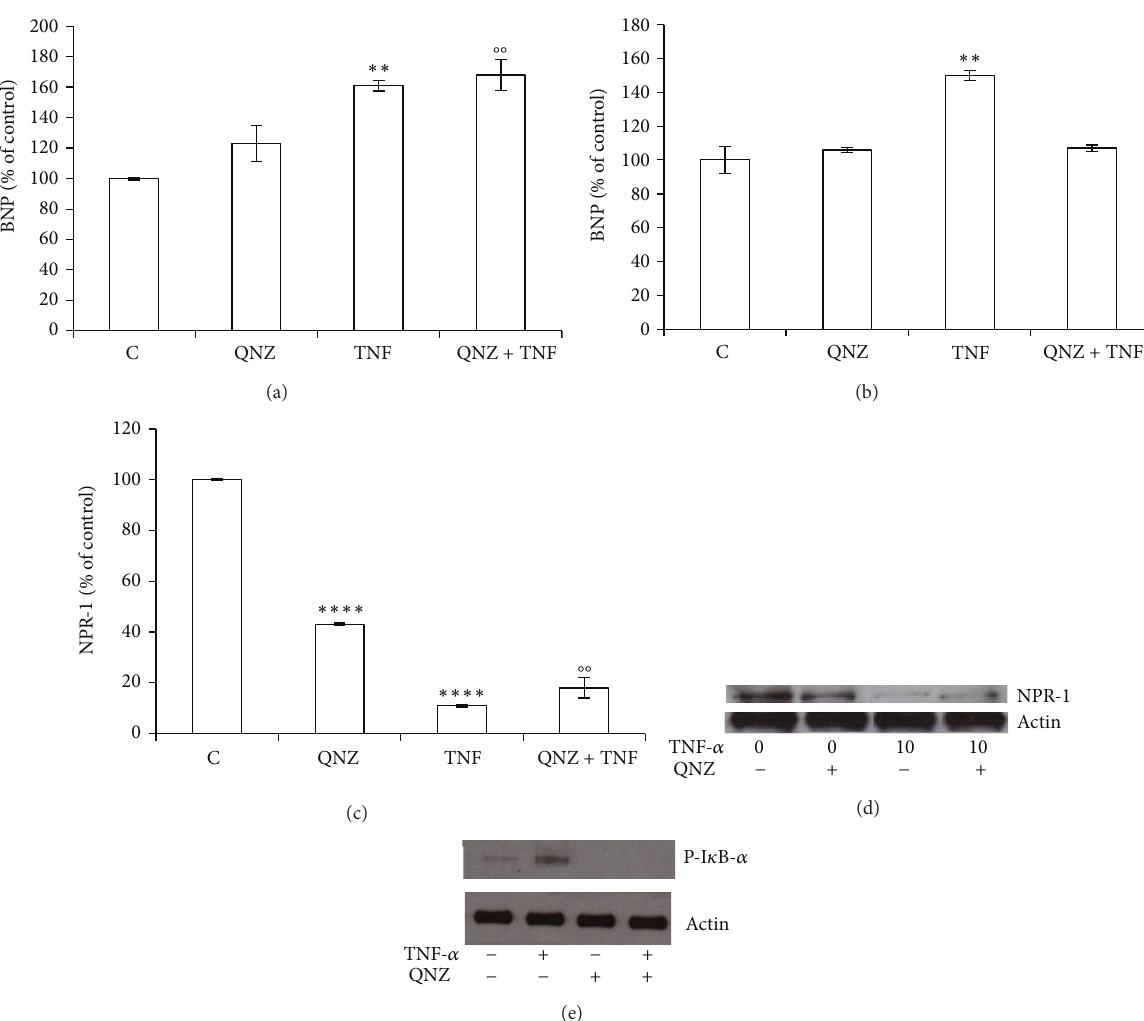
Figure 4: TNF- 𝛼 modulation of protein levels of BNP and NPR-1 may require activation of NF- 𝜅 B pathway. BEAS-2B cells were treated 10ng/mL TNF- 𝛼 alone or in combination with the inhibitor QNZ (10 𝜇 M), for 24h. ((a), (b)) BNP, ((c), (d)) NPR-1 gene expression at mRNA ((a), (c)) and protein ((b), (d)) level, and (e) Phospho-I 𝜅 B- 𝛼 protein level. Western blots were obtained by using the specific rabbit polyclonal or monoclonal Abs. The blots were stripped of the bound Ab and reprobed with mouse anti- 𝛽 -actin, to confirm equal loading. Western blots arerepresentativeofthreeseparateexperiments.Allhistogramsindicatemeans ± SDofthreedifferentcultureseachonetestedinquadruplicate and expressed as percentage of control ( ∗∗ 𝑃 < 0.01 , and ∗∗∗∗ 𝑃 < 0.0001 versus Controls). ( ∘∘ 𝑃 < 0.01 versus QNZ). C: Controls (untreated